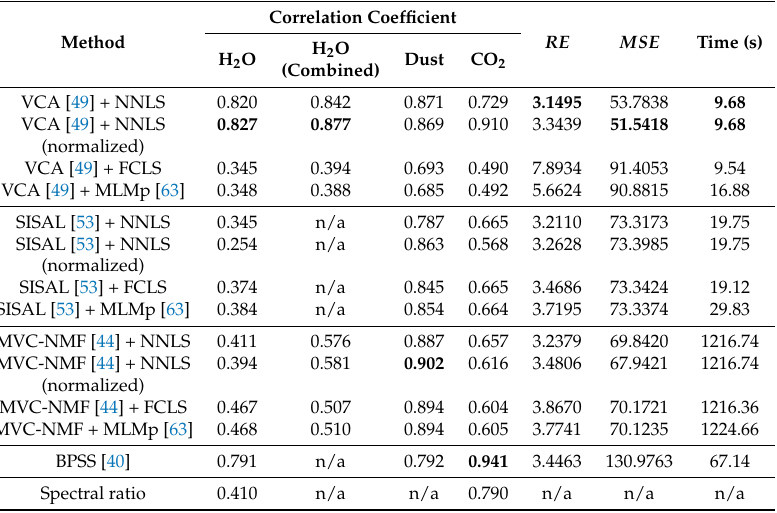
Table 11. Unmixing performance of different models for the ORB0041 image: correlation coefficients, RE, MSE and time (in second). A bold face stresses, in each case, the best result (correlation coefficients between the abundances computed by the spectral unmixing and spectral index approaches and the reference abundances generated by GRSIR with a physical